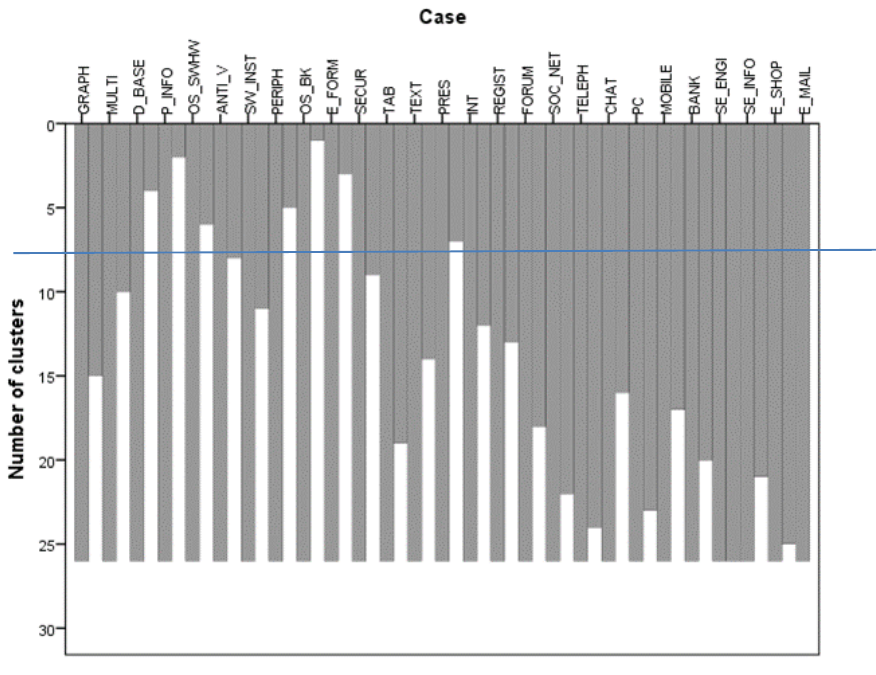
Fig. 2. Cluster analysis of competences